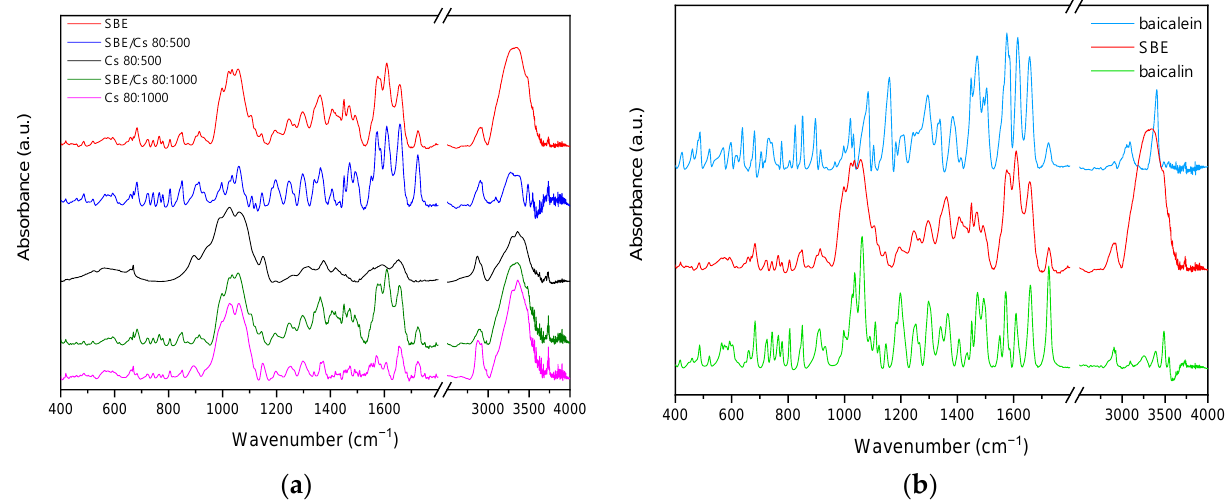
Figure 2. ATR-FTIR spectra of ( a ) binary mixtures and chitosans; ( b ) S. baicalensis radix extract, baicalin, and